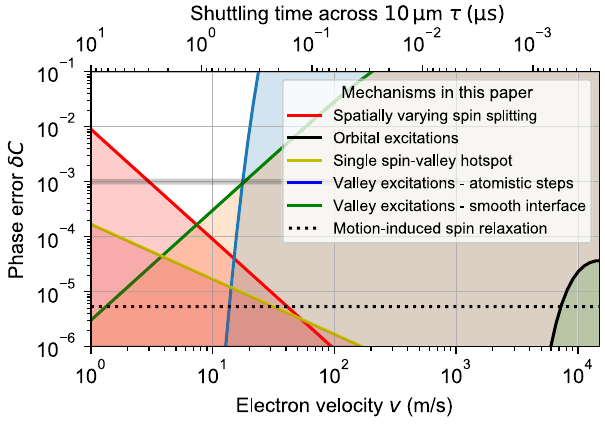
FIG. 1. Sketch of the transfer errors of an electron spin-qubit after 10- µ m shuttling in the CB mode as a function of the shut- tling velocity for various decoherence mechanisms discussed in this paper. In Sec. VIII, we discuss the detailed plots of these dependencies that summarize all the calculations in this